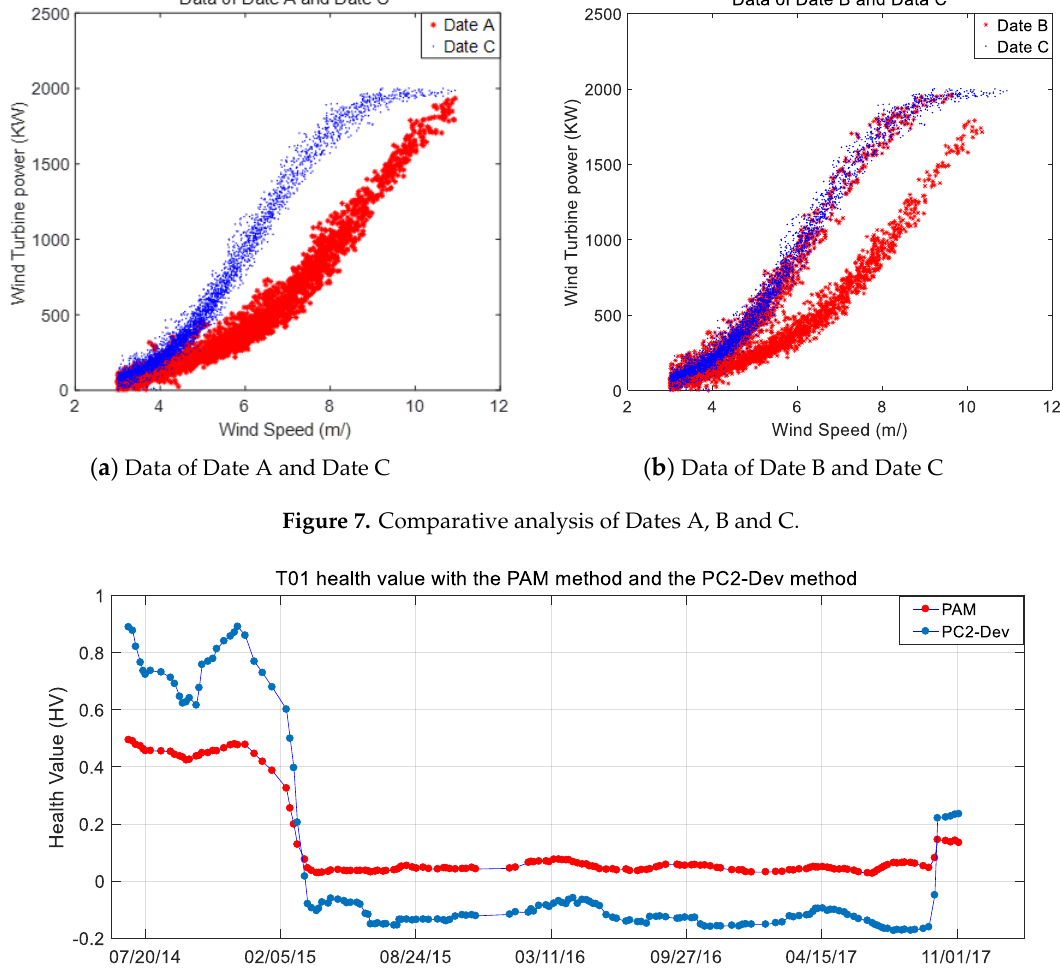
Figure 8. Health assessment result of T01 wind turbine obtained using two methods.